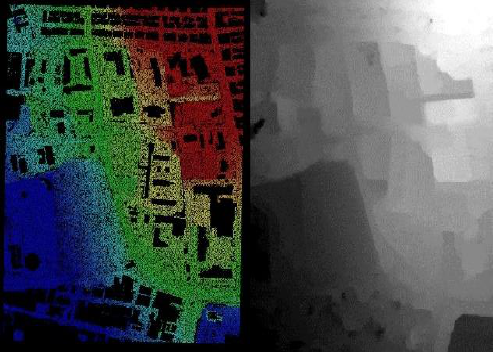
Figure 8. Filtered LiDAR data and generated DEM for G21 site.